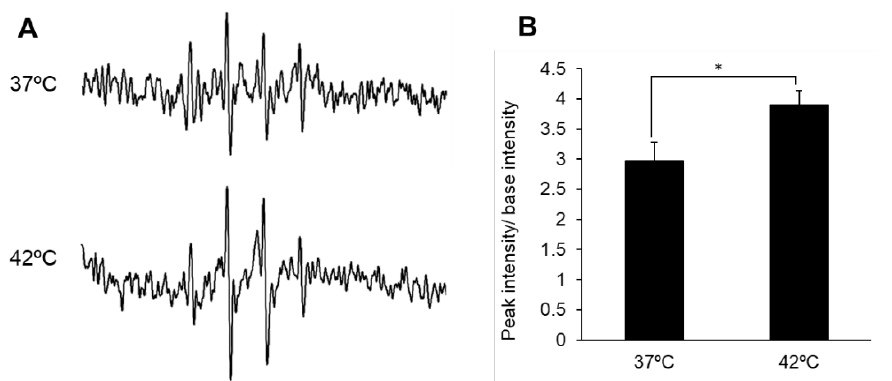
Figure 1. Intracellular ROS production after HT treatment. ( A ) The ESR signal of 4T1 cell; ( B ) The relative ESR signal. Data are expressed as means ± SD ( n = 3). * p < 0.05. Student’s t -test.